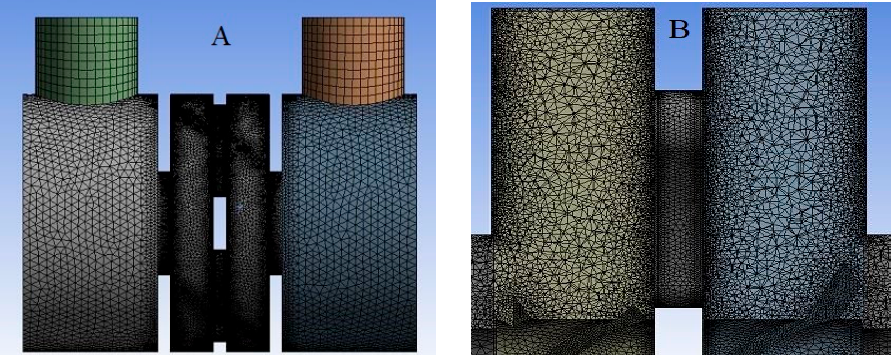
Figure 3. Created grids for the simulations ( A )—overall view, ( B )—Cross-sectional view.